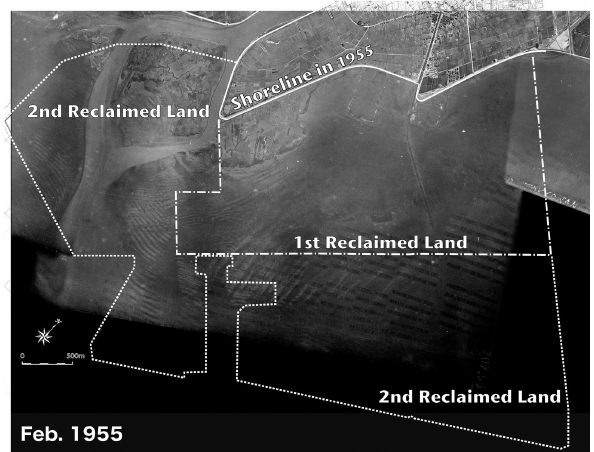
Figure 2. Original shoreline and the reclaimed land in Urayasu City (The aerial photo by Kokusai-kogyo co. ltd.).